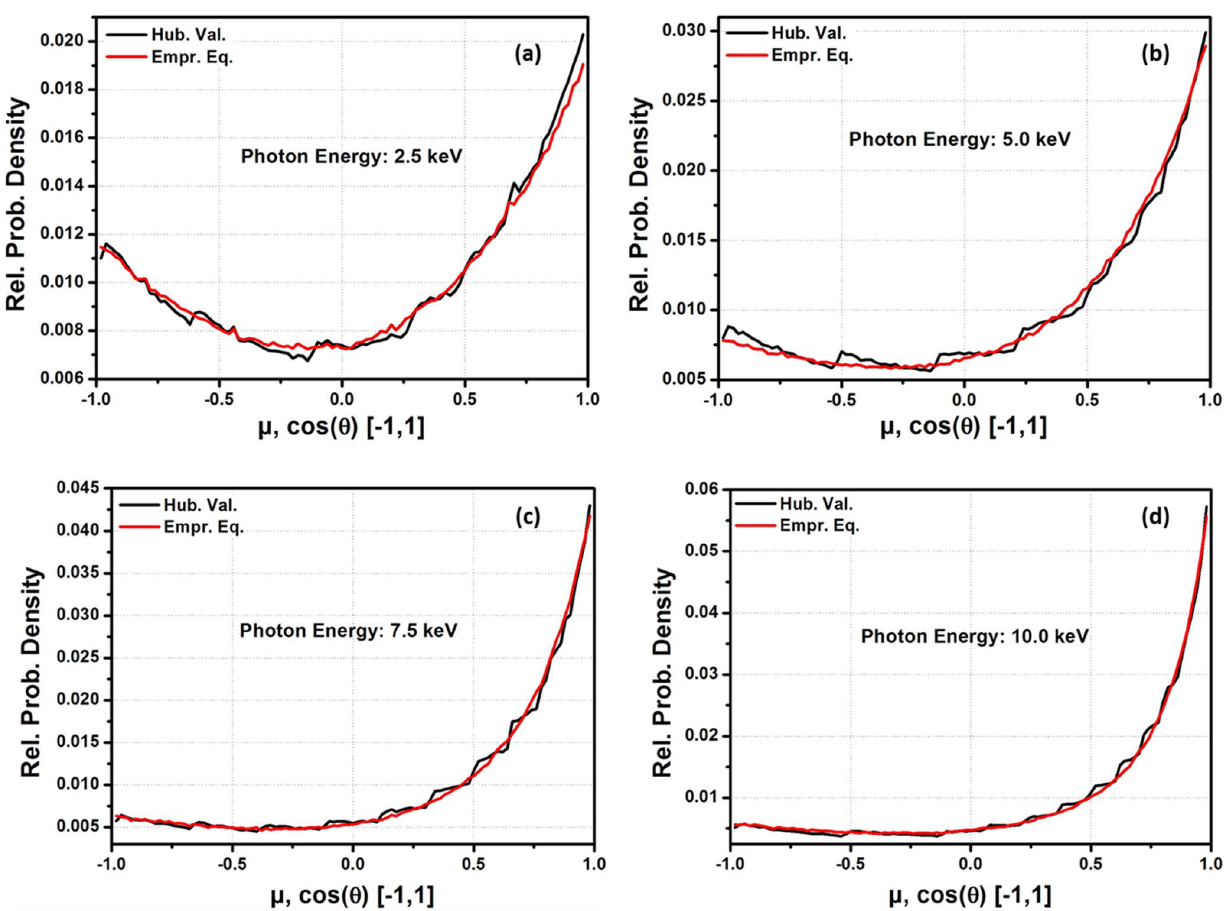
Figure 6. Angle distribution of coherently scattered photons for a source of 1 million photons by using F H ( q i , Z ) for ‘ q ’ from 0 to 16.0 A˚ 2 1 and Empirical equation data for Manganese (Mn, Z=25) as a scatter element. (a) energy=0.0025 MeV, (b) energy=0.005 MeV, (c) energy=0.0075 MeV, (d) energy=0.01 MeV.